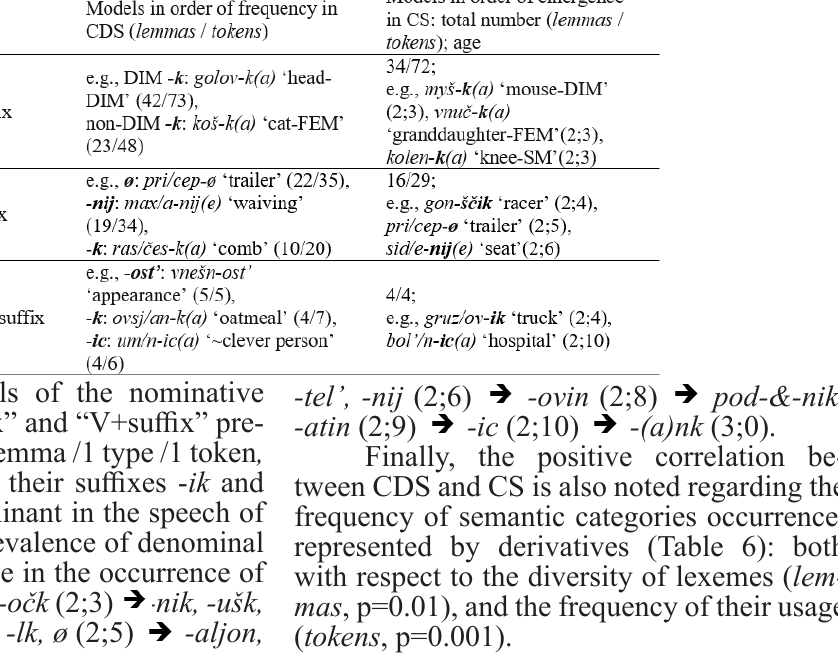
Table 6. Frequency of semantic categories of derivatives (% of new